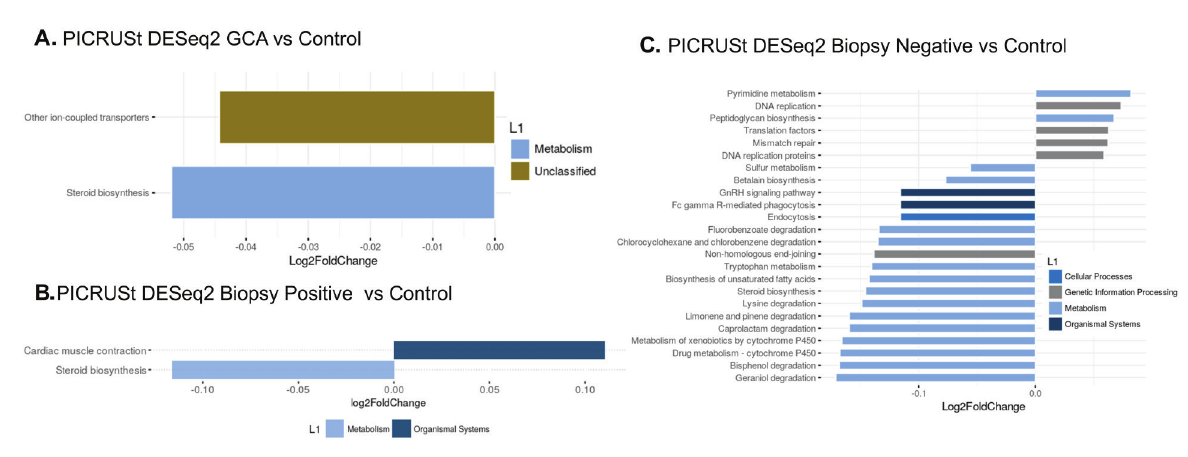
Figure 4. Predicted functional pathways differentially represented in GCA TA compared to con- trol (non-GCA) TA. Representation of PICRUSt DESeq2 analysis yielding relatively under-represented functional pathways in (A) GCA TA compared to control TA, (B) biopsy-positive GCA TA compared to control TA and (C) biopsy-negative GCA TA versus control